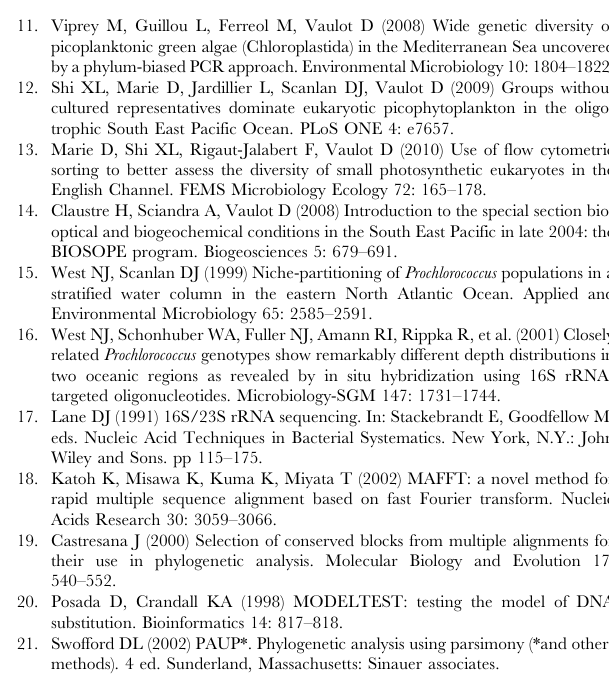
Figure S1 Specificity of the primers OXY107F and PLA491F, illustrated by alignment of the primers against algal plastid and cyanobacterial 16S rRNA gene sequences. Note that there are more sequences for PLA491F because this region is better covered by publicly available sequences. Table S1 Plastid 16S rRNA gene sequences obtained from BIOSOPE sorted samples (Bacteria excluded). OTU assignment is based on FastGroup II results with 80% similarity. Taxonomic assignments have been made based on the information from BLAST and from an annotated database. Table S2 Plastid 16S rRNA gene sequences representative of OTUs obtained from BIOSOPE sorted samples (Bacteria